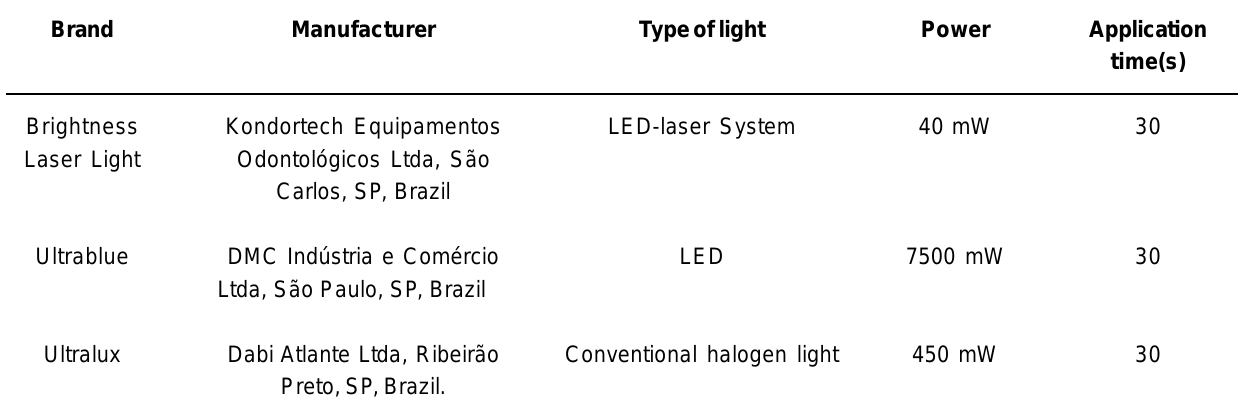
TABLE 1- Light sources evaluated in the